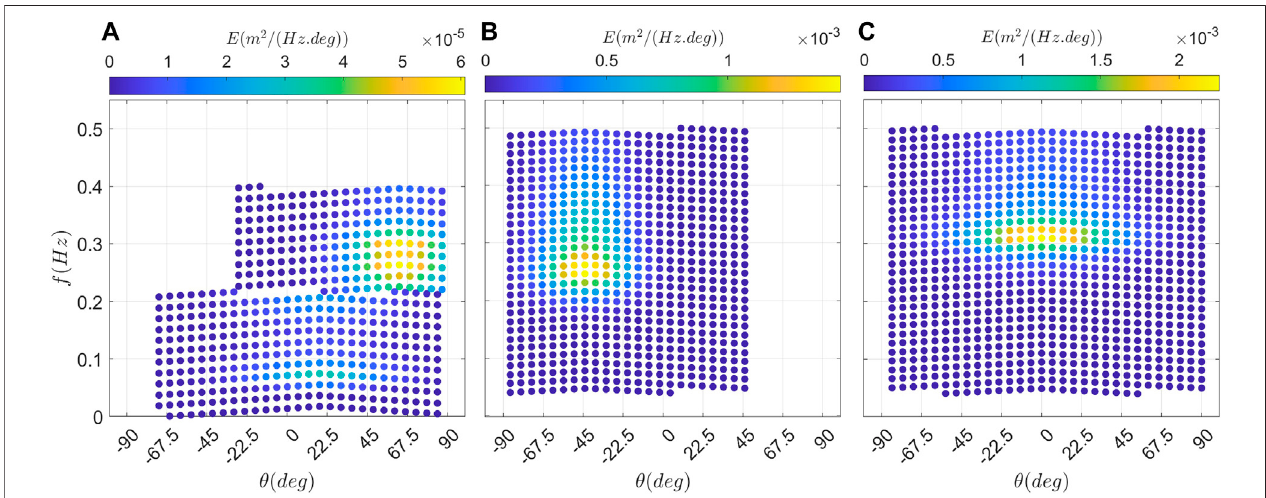
FIGURE 4 | Wave energy spectra at the offshore boundary for (A) Case 1, (B) Case 2, and (C) Case 3.